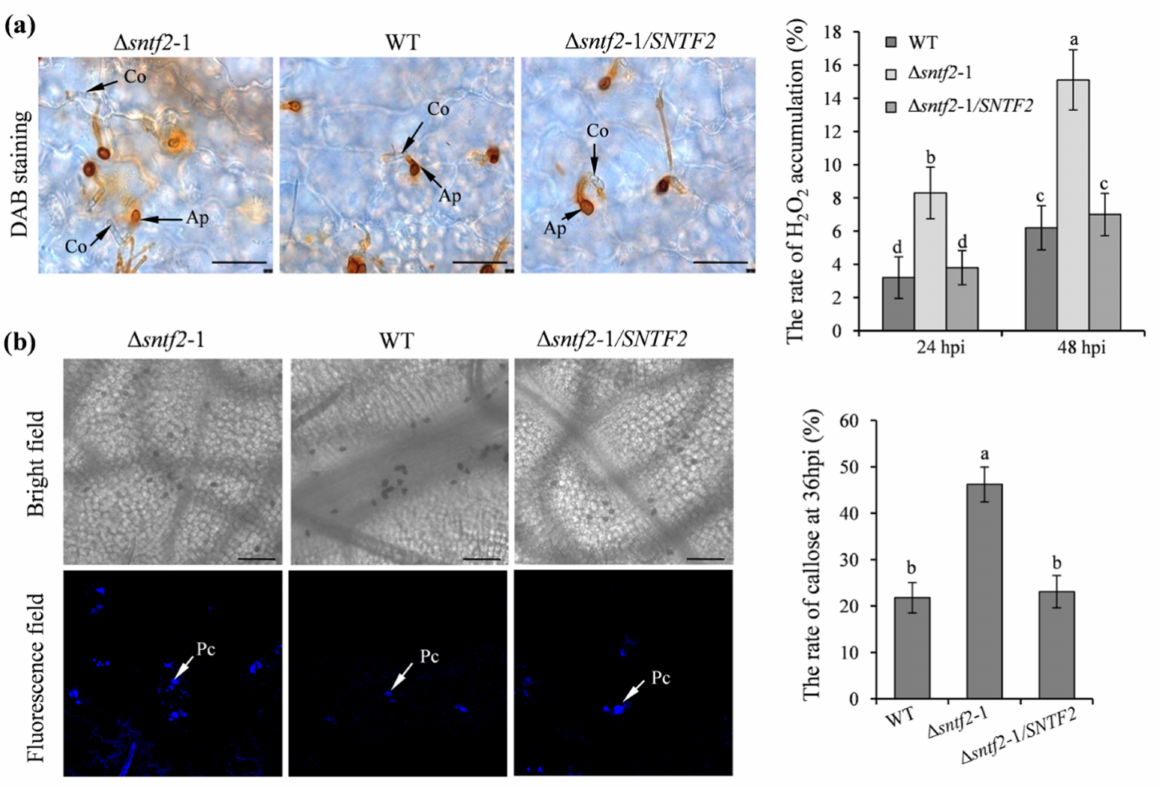
Figure 4. The H 2 O 2 accumulation and callose deposition in apple leaves during the infection. ( a ) DAB staining was performed to detect H 2 O 2 accumulation on apple leaves. DAB oxidation led to brownish polymer formation that was deposited at the site of H 2 O 2 accumulation. Co: conidia; Ap: appressorium; bar: 50 µ m. ( b ) Aniline blue staining was to observe callose deposition on apple leaves at 36 hpi. Apple leaves were inoculated with WT, ∆ sntf2 -1, ∆ sntf2 -2, ∆ sntf2 -3, or ∆ sntf2 -1/ SNTF2 strains. Pc: callose deposition; bar: 50 µ m. The rate of H 2 O 2 accumulation and callose formation was evaluated. Error bars represent standard deviations. Lowercase letters represent significant differences ( p <